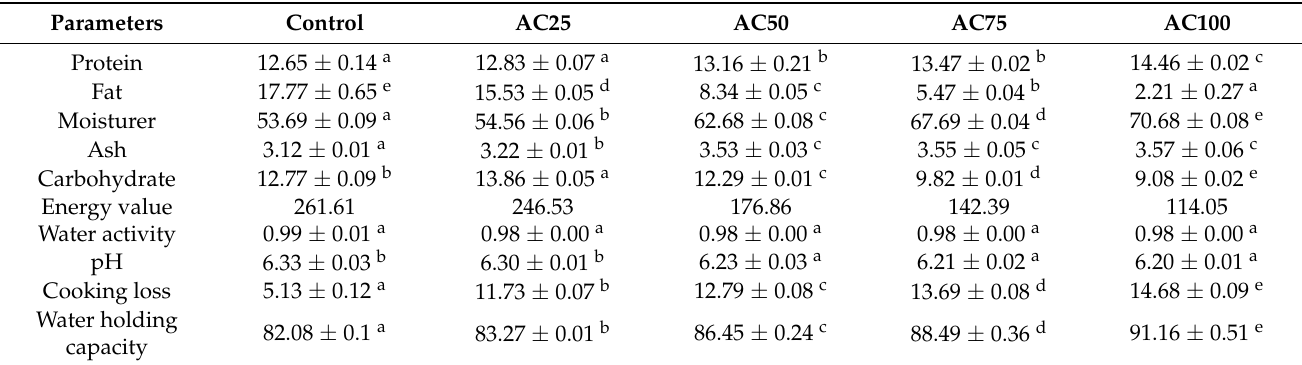
Table 2. Proximate composition (%), energy value (kcal/100 g of the product), water activity, pH, cooking loss and water holding capacity of sausages with replacement of pork fat by Auricularia cornea